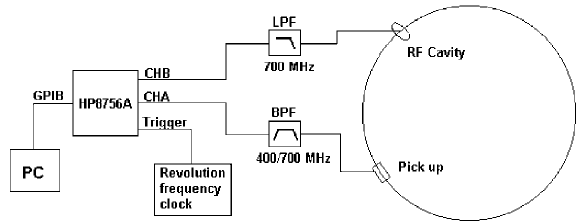
FIG. 2. Experimental setup for the synchronous phase